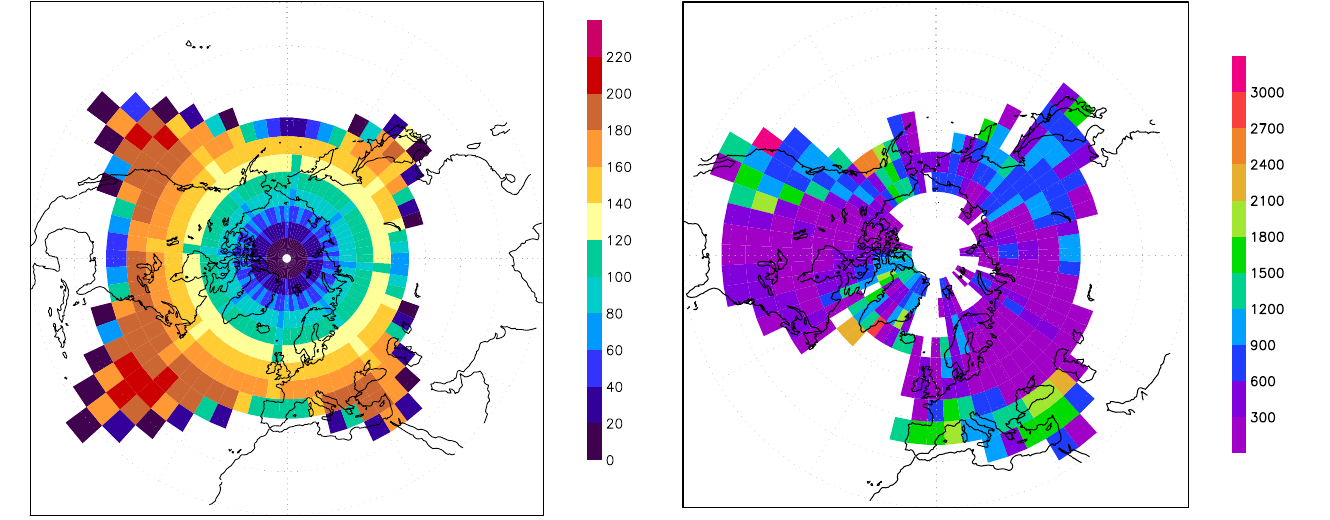
Figure 2. Number of GRISLI cells per ECBilt cells on the Northern Hemisphere GRISLI grid. The figure shows nicely that the highest number of GRISLI cells per ECBilt cell is reached close to the cor- ners of the GRISLI grid, situated over the oceans in ECBilt under the present-day configuration. The low numbers at the very edge of the grid are due to the partial overlap of the two grids there.